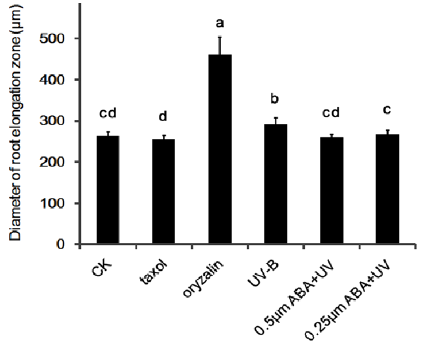
Figure 6. Effects of ABA and UV-B radiation on the root diameter of wild-type seedlings compared to those of taxol and oryzalin treatments. The diameters of the root transition zone of different treated seedlings were measured 24 h post-radiation by image processing software Image J. The data were statistically analyzed by data analysis software IBM SPSS Statistics 27. Untreated seedlings were used as control (CK). Each experiment was repeated three times. All the statistical analyses were conducted using the IBM SPSS Statistics 27 software. All values are expressed as the mean ± SE ( n ≥ 27). And letters of a–d represent statistically significant groupings of p ≤ 0.05 based on a one-way ANOVA with the LSD multiple range